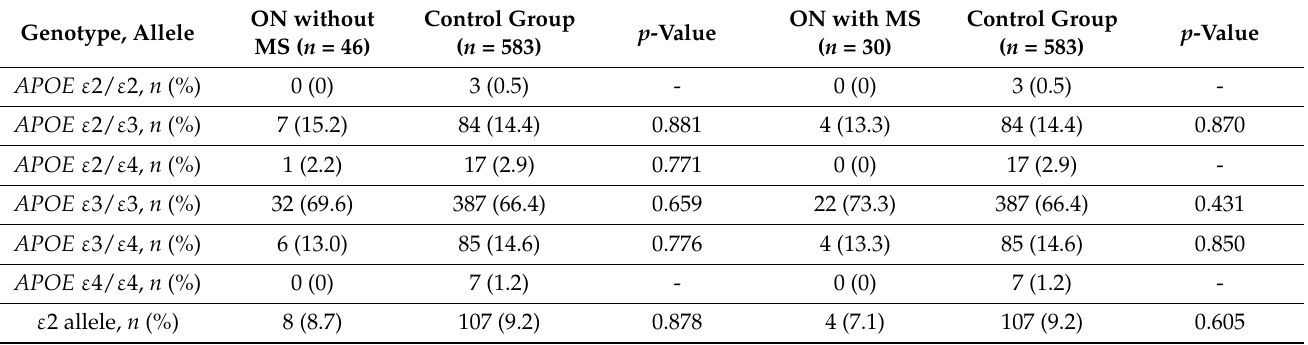
Table 6. APOE genotype and allele frequencies in patients with ON with MS and without